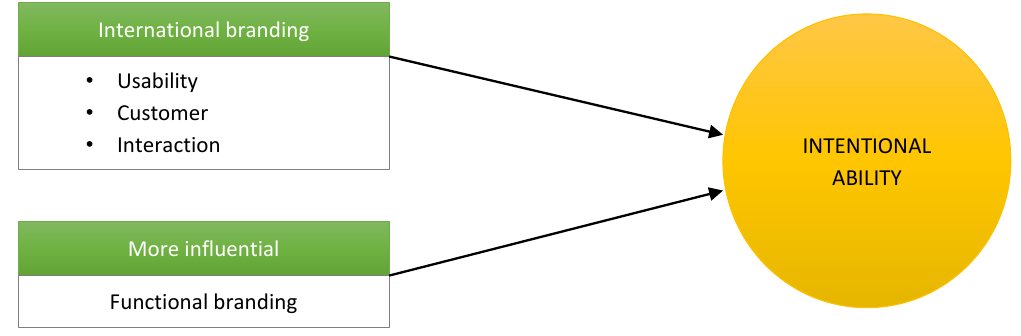
Figure 1. Conceptual framework relating functional branding and intentional branding variables Table 2. Frequency and percentage of sample characteristics according to education